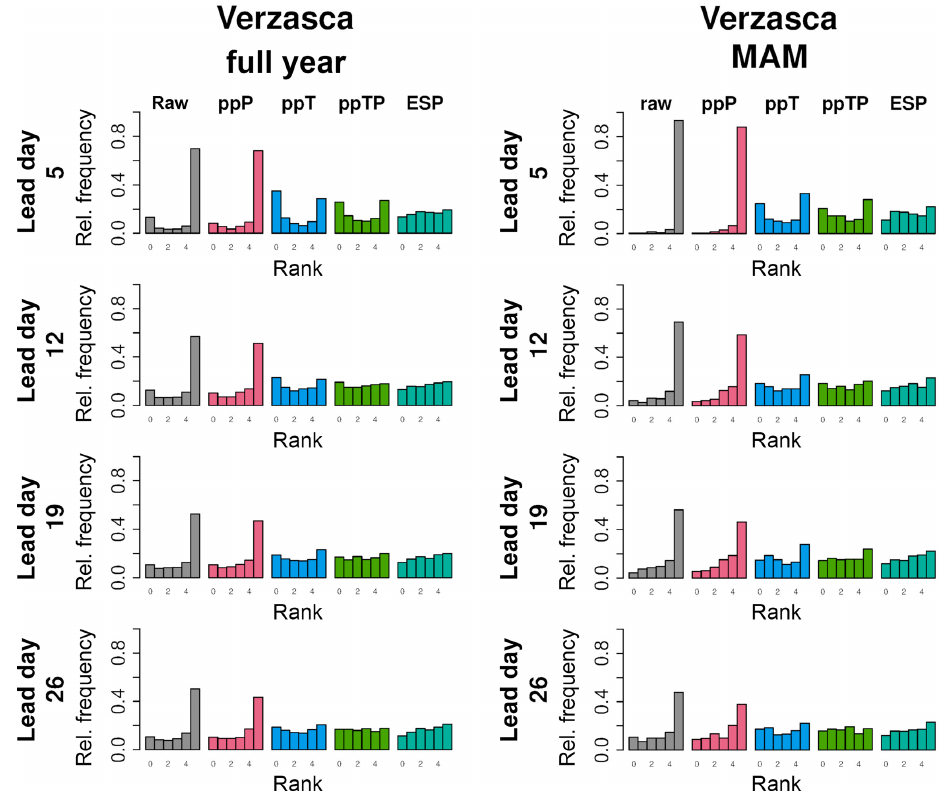
Figure 7. Rank histograms for all four configurations (raw, ppP, ppT, ppTP) and the ESPs for the full analysis period (Full year) and MAM in the Verzasca catchment. The basic principle in the rank histograms the assumption that the ensemble members determine bins in which the corresponding observation can be ranked. For a reliable forecast, the observations are equally distributed across all different bins resulting in a uniform shape of the rank histograms. If for example the frequency in the lowest (rank 0) and the highest bin (rank 6) is much higher, the observation tends to be more frequently either higher than all ensemble members or lower than all ensemble members but less often in between the ensemble members. This specific U-shape indicates that the forecast spread is too narrow and thus the forecasts generally overconfident. In contrast, if the observations tend to be more often in between the ensemble members (e.g. rank 2 and 3), the rank histogram exhibit a convex shape and thus the forecast spread is too large indicating overdispersive